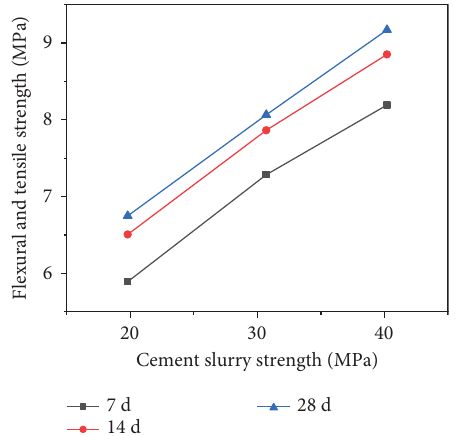
Figure 12: Variation curve of fexural tensile strength with cement slurry strength. Table 17: Data processing results for beam bending tests at diferent cement slurry strengths. Cement slurry strength